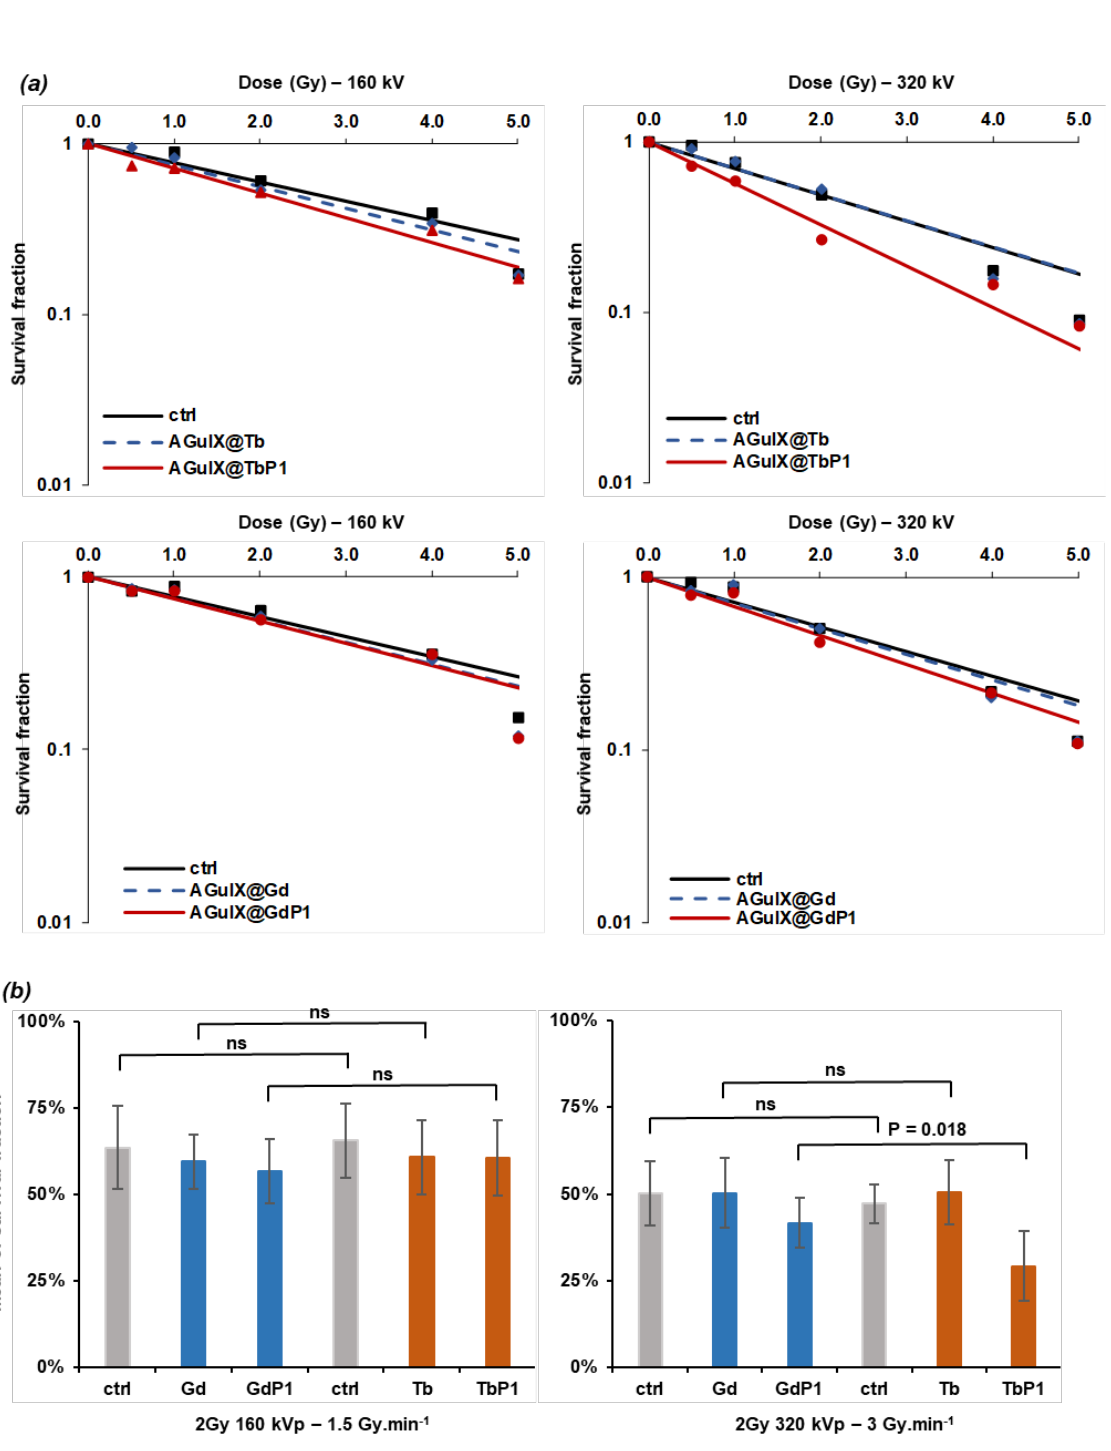
Figure 7. Survival curve of pre-treated U-251 MG cells with AGuIX@Tb-P1 or AGuIX@Gd-P1 exposed to X-ray irradiation. ( a ) LQ model established after numeration of cell clones obtained for AGuIX@-complexes pre-treated cells, then irradiated at 160 and 320 KVp for a range of 0.5 to 5.0 Gy. ( b ) Means of survival fraction at 2.0 Gy were compared using the Kruskal-Wallis test (with α = 0.05), and post-hoc by the Mann-Whitney test (α = 0.05) for unpaired groups ( n = 12 wells per condition from at least 4 independent experiments). Abbreviation: ctrl, irradiated cells without nanoparticles pre-treatment.